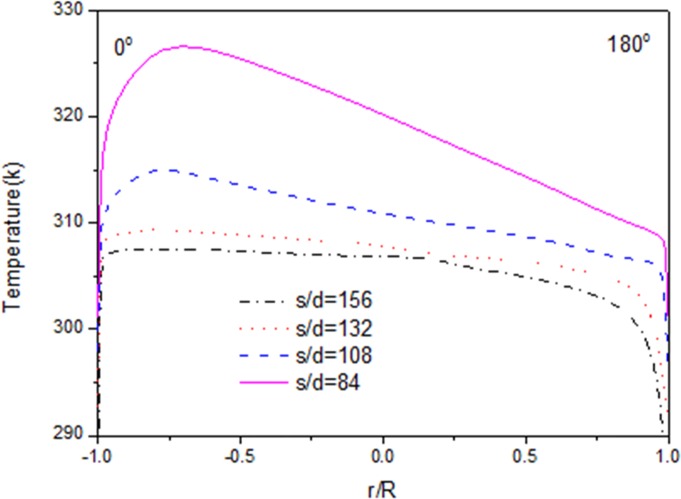
Radial distributions of fluid temperature.